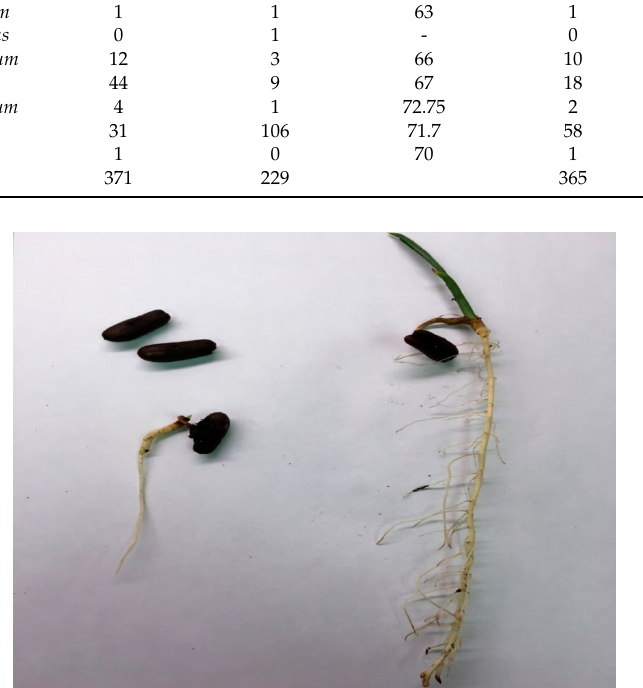
Figure 1. Lack of germination and slow development caused by Aspergillus sect. Nigri (left) versus a typical, fungus-free seedling at same time (right).